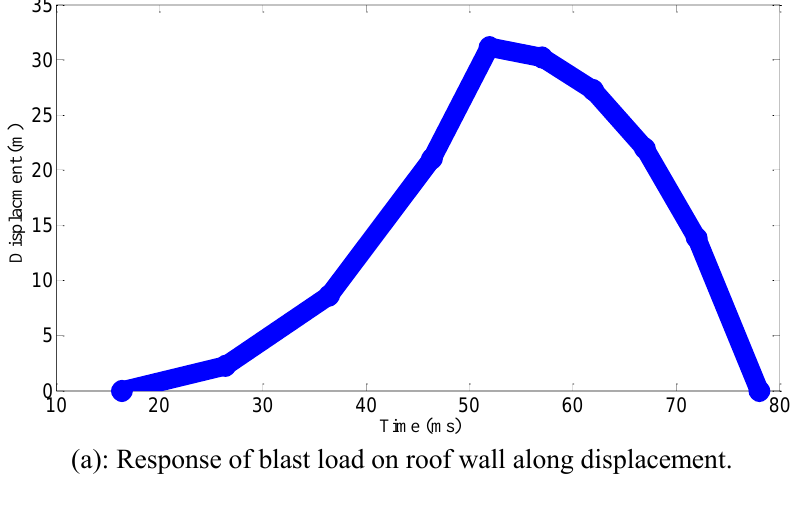
(a): Response of blast load on roof wall along displacement.